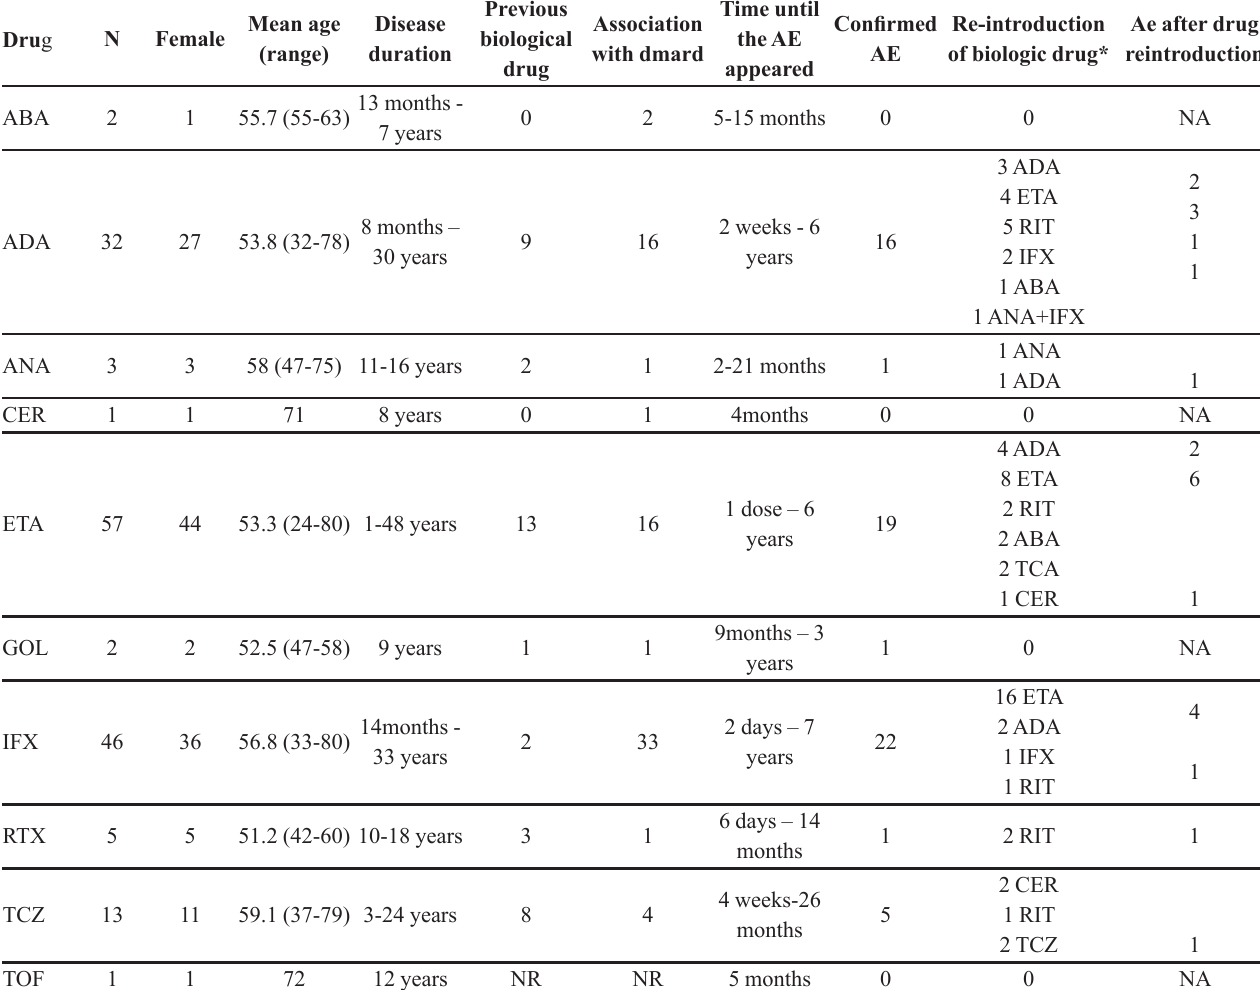
TABLE I - Characteristics of included case